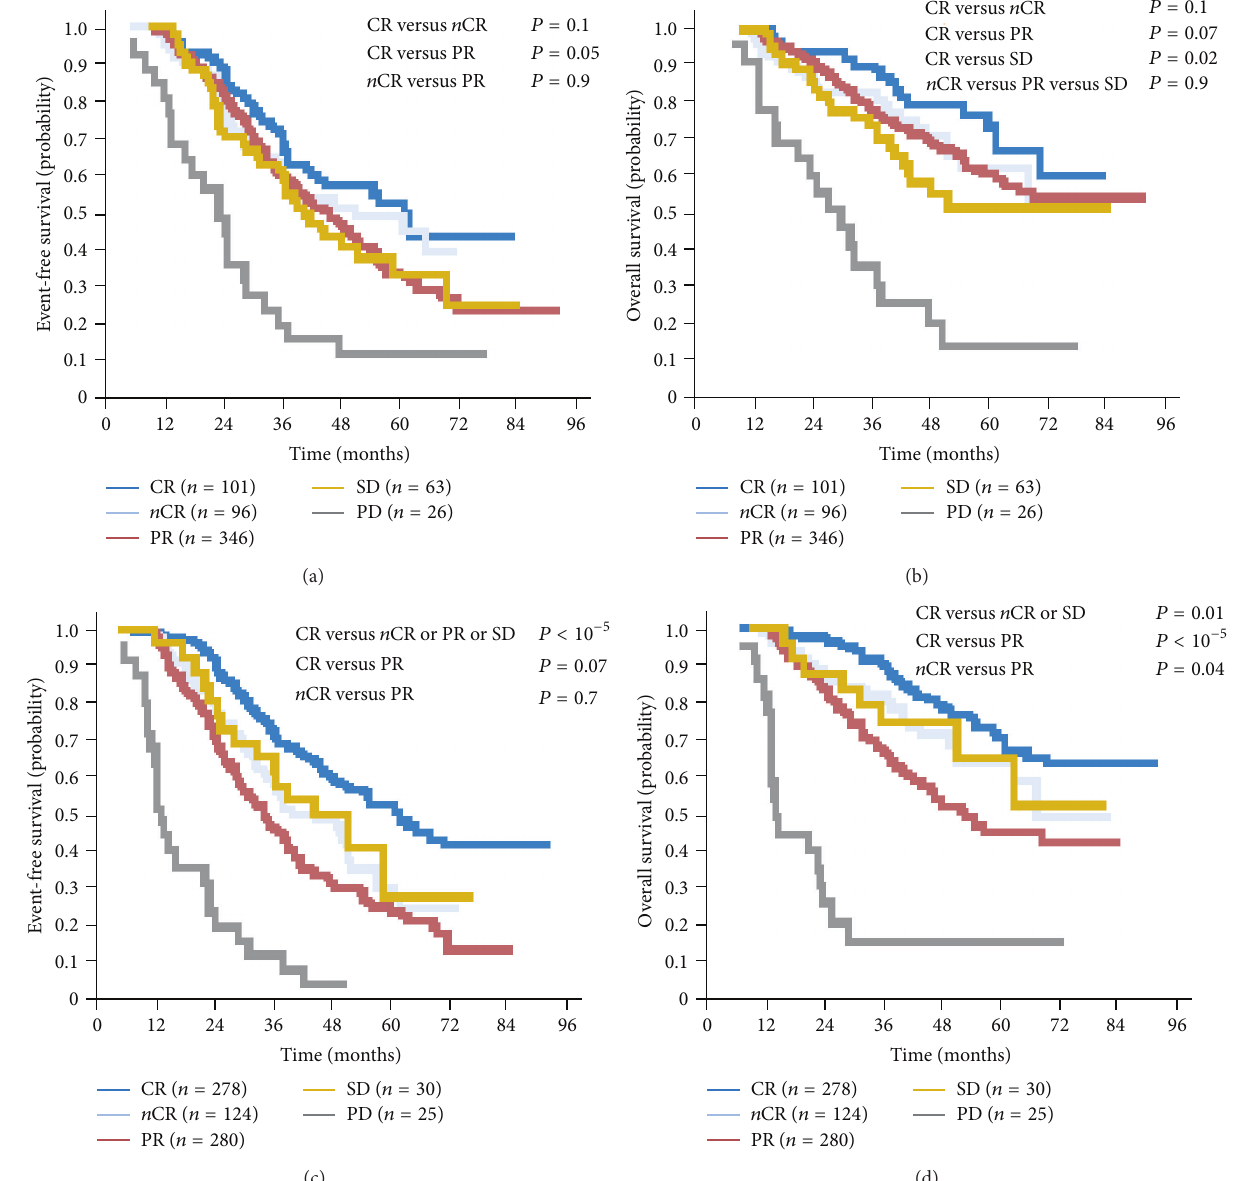
Figure 1: Achievement of CR is associated with improvement in survival outcomes after induction as well as after ASCT (adapted with permission from